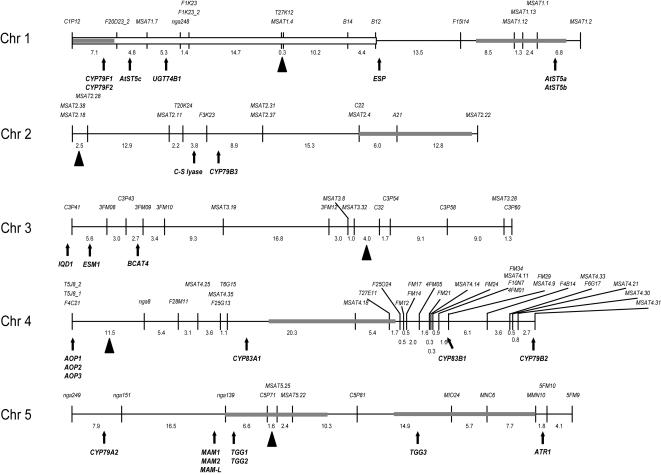
Genetic map of Da(1)-12×Ei-2 recombinant inbred lines.Shown are markers and genetic distances between adjacent markers along the chromosomes. Triangles indicate the approximate location of centromeres. The white bar for chromosome 1 indicates a region with marker distortion. Grey bars indicate 2-LOD support intervals for Pieris resistance QTL. Known genes involved in glucosinolate biosynthesis, hydrolysis, and gene regulation are shown below chromosomes; explanations, AGI numbers and references are given in Table S2.